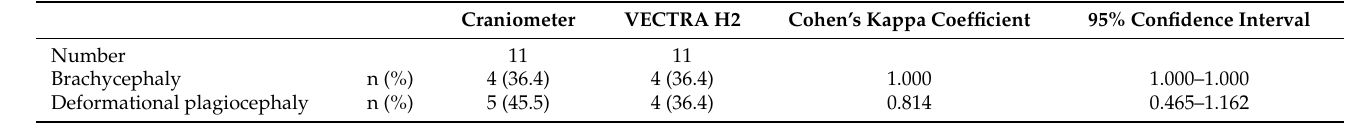
Table 3. Evaluation of inspection accuracy in Cohen’s kappa coefficient.